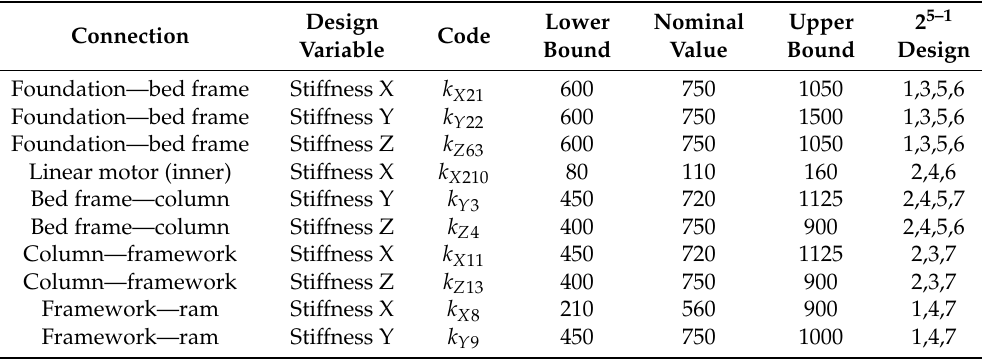
Table 5. List of variables used in fractional factorial designs 2 5 − 1 .